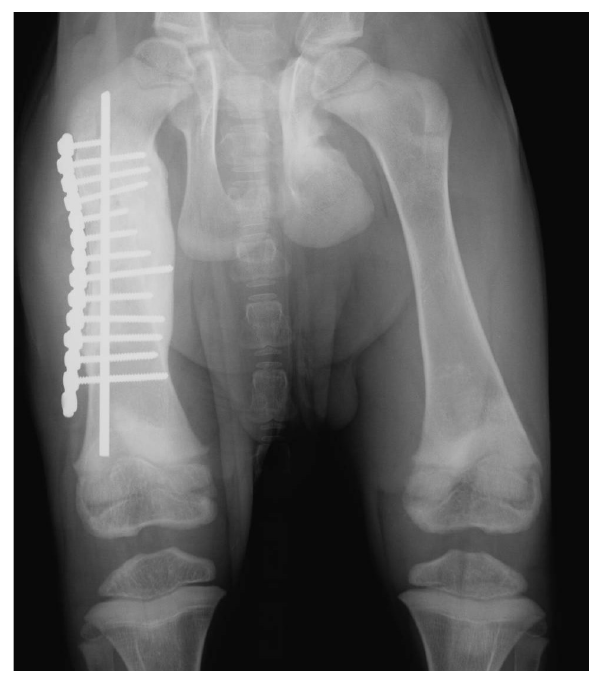
FIGURE 3: Ventro-dorsal view of the pelvis of the female cub on day 63 after surgical repair.